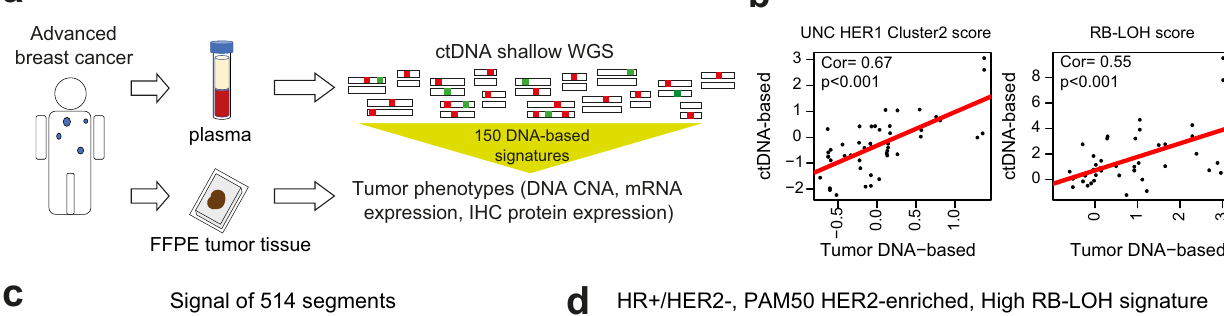
ctDNA-based data versus tissue RNA-based expression data RNA-based expression data from FFPE tissue using a research-based PAM50 intrinsic subtype assay 15 was available for 108 cases with a TF ≥ 3% in plasma. Tissue samples were obtained at various time-